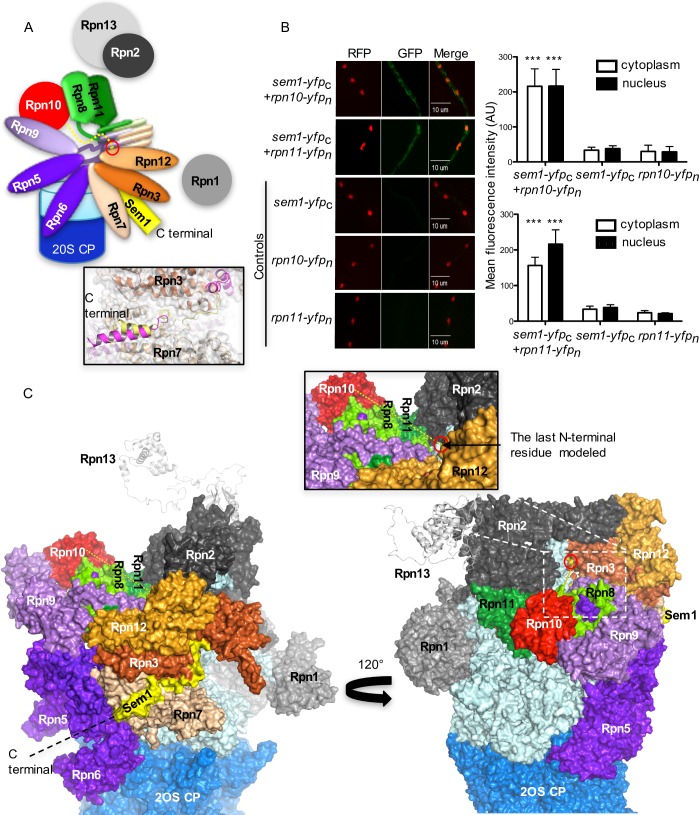
Sem1 interacts in vivo with Rpn10 and Rpn11.(A) Schematic model of the orientation of N- and C-termini of Sem1 (yellow) within the lid associated to the base (light blue) and the 20 core particle of the 26S proteasome. The red circle represents the last N-terminal amino acid residue modelled in Sem1. Zoomed in positions of the C-terminal region of human (Dss1 in magenta) and yeast (yellow) Sem1 are depicted in frame. (B) Bimolecular fluorescence complementation studies (BiFC) of Sem1 fusion proteins with the C-terminal half of yellow fluorescent protein co-expressed with either Rpn10 or Rpn11 fusions to N-terminal YFP result in specific signals corroborating physical interaction in fungal cells (A. nidulans strains: sem1-yfpc+rpn10-yfpn or sem1-yfpc+rpn11-yfpn). Nuclei were visualized in red by expression of rfp-h2A. The fluorescence intensities both in the cytoplasm and nucleus for the indicated strains are shown as mean fluorescence intensity. Significance of differences was calculated with t-test compared to the control strains expressing either sem1-yfpc, rpn10-yfpn or rpn11-yfpn, ***p<0.001, n = 10. Significantly higher fluorescence was observed in sem1-yfpc+rpn10-yfpn or sem1-yfpc+rpn11-yfpn compared to the control strains. (C) Homology model of the 26S proteasome from A. nidulans based on the human proteasome cryoEM structure (EMDB-4002, PDBs: 5L4K and 5L46). The model depicts two surface representations of the 19S RP with C-terminal region of Sem1 located at the interface formed by the N-terminal domain of Rpn3 and Rpn7 (yellow surface). The model of Sem1 is missing the N-terminally fragment of approximately 30 residues. 120° rotation depicts the last N-terminal amino acid residue modelled, located in a cleft formed by Rpn3 (red circle). It is conceivable that the missing N-terminal region of Sem1 can pass through this cleft and form interactions with Rpn10 and Rpn11 within the lid (dashed yellow line).